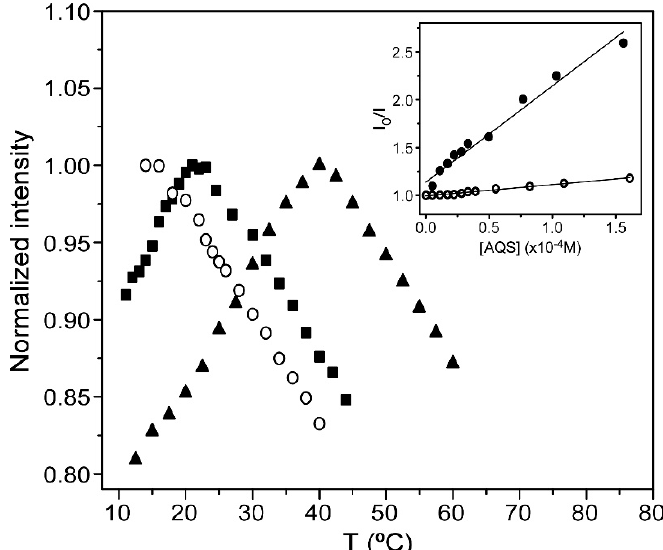
Figure 9. Effect of temperature on the fluorescence emission maximum of HTMA-PFBT in LUVs of DOPG (circles), 1,2-Dimyristoyl-sn-glycero-3-phospho-rac-(1-glycerol) sodium salt (DMPG) (squares) and 1,2-Dipalmitoyl-sn-glycero-3-phospho-rac-(1-glycerol) sodium salt (DPPG) (triangles). Inset: Stern-Volmer of the quenching of HTMA-PFBT with AQS in DMPG LUVs at 15 °C (circles) and 35 °C (hollow circles).